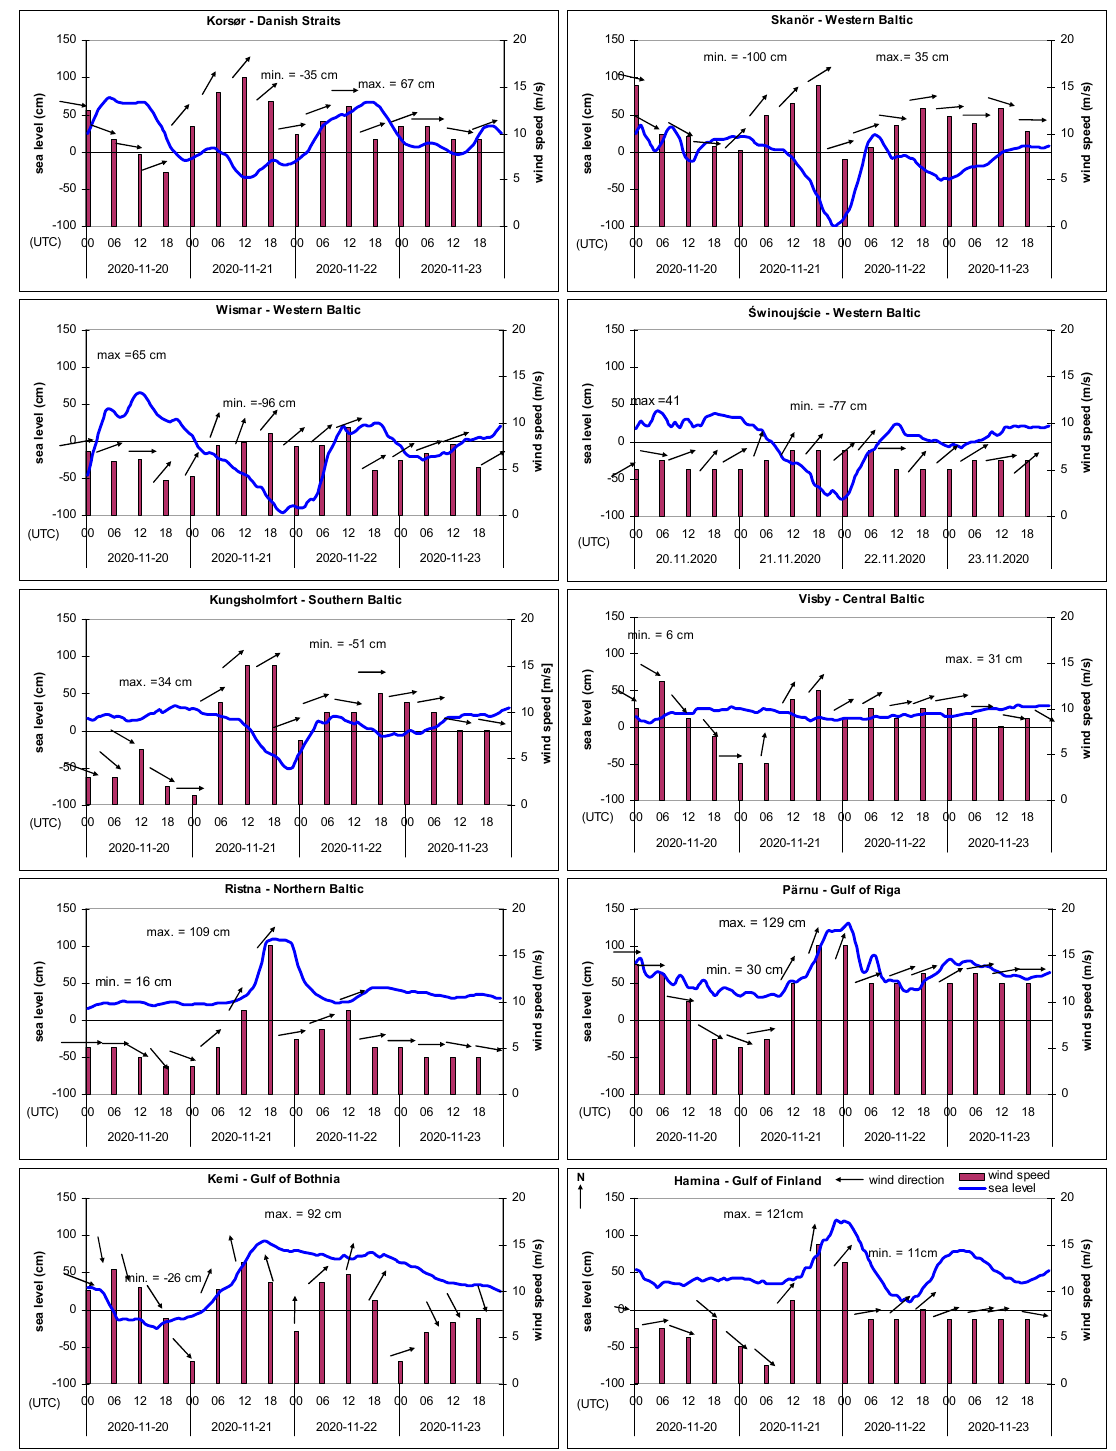
Figure 7. Sea level changes at representative stations in the main basins of the Baltic Sea from 20 to 23 November 2020. (Alternating, seiche-like sea level oscillations between the southwestern and northeastern Baltic coasts).